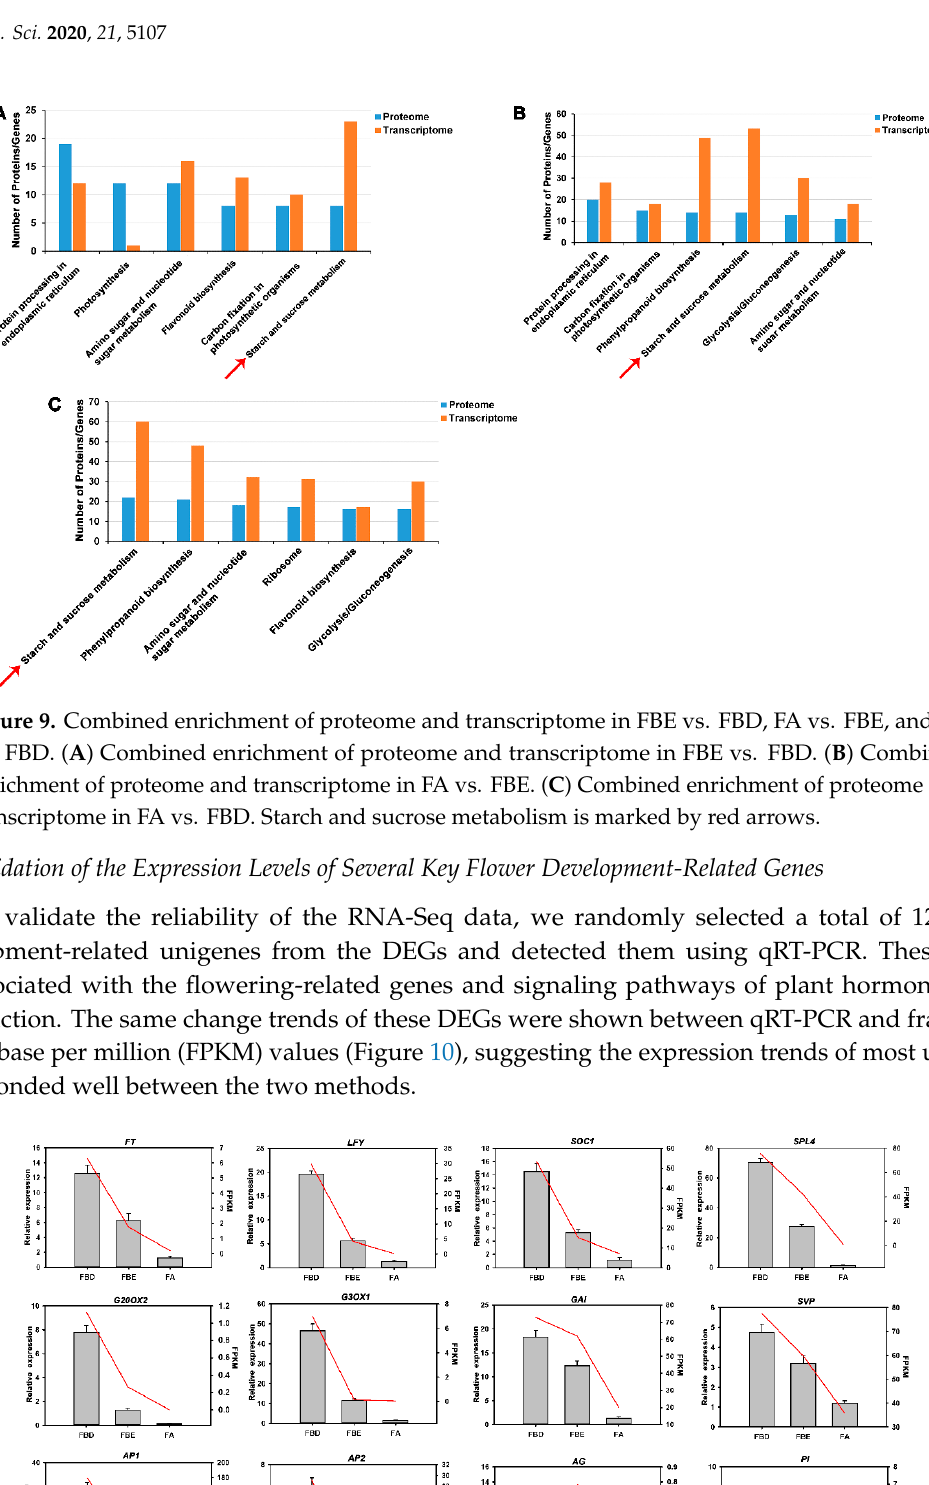
Figure 8. Correlation for proteome and transcriptome, differentially accumulated proteins (DAPs), and DEGs of FBE vs. FBD, FA vs. FBE, and FA vs. FBD. ( A – C ) Correlation for proteome and transcriptome of FBE vs. FBD, FA vs. FBE, and FA vs. FBD. ( D – F ) Correlation for DAPs and DEGs of FBE vs. FBD, FA vs. FBE, and FA vs. FBD.